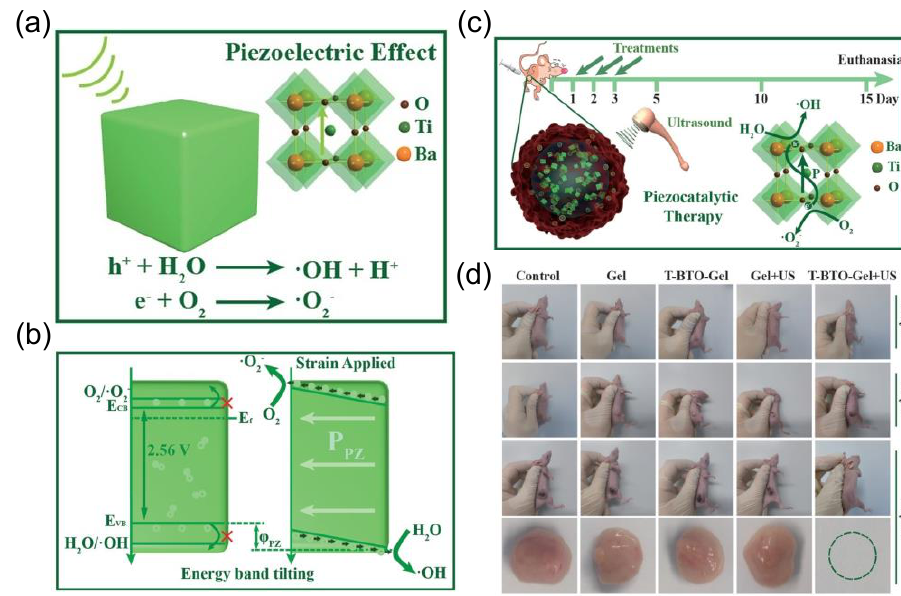
Figure 6. ( a ) Schematic diagram of •OH and •O 2− generated on T−BTO under ultrasonic conditions. ( b ) Energy band bending under ultrasonication. ( c ) Schematic diagram of piezoelectric therapy for tumor. ( d ) Tumor treatment results under different conditions. Reproduced with permission [38] .